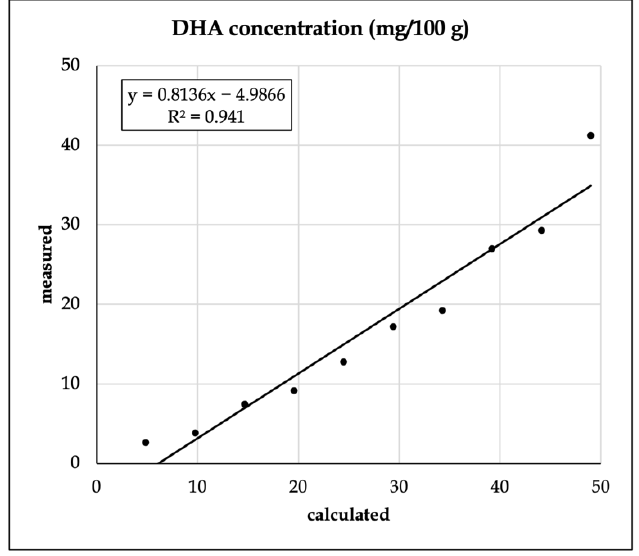
Figure 1. Recovery of docosahexaenoic acid (C22:6 n3, DHA) from the enriched vanilla shake product.